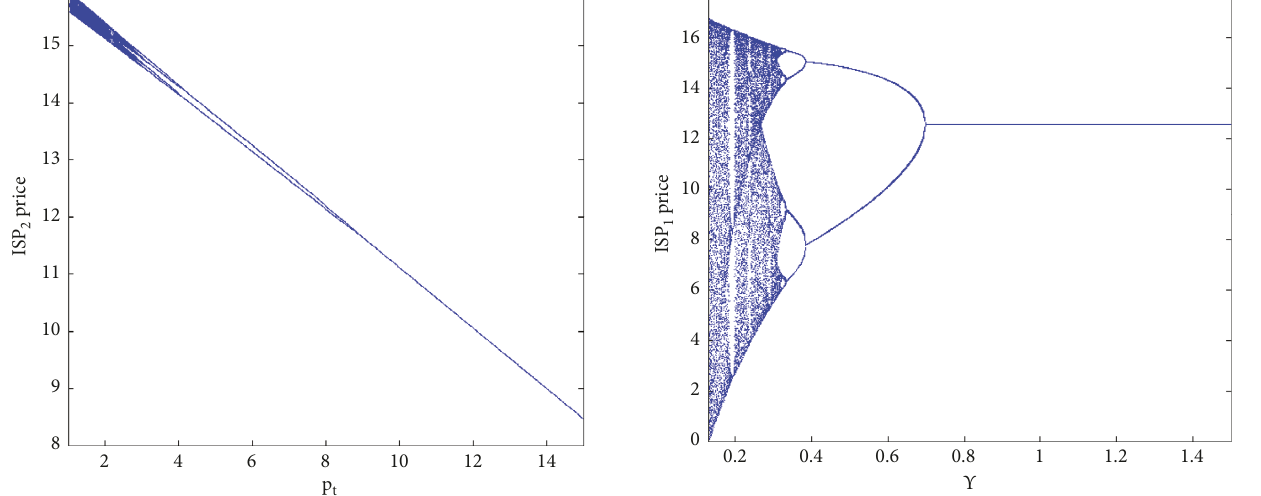
with respect to Υ . 1